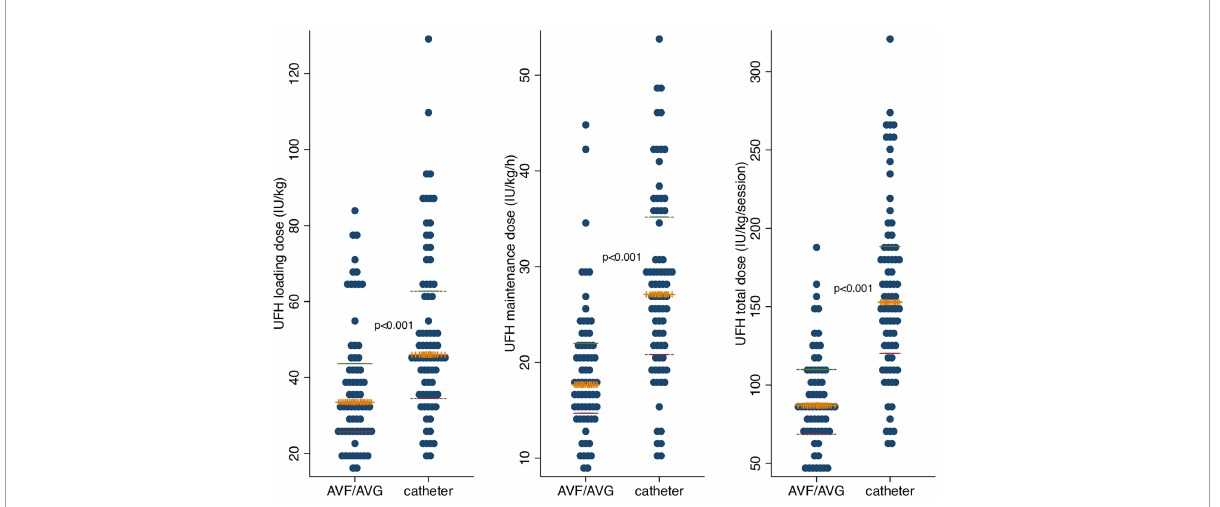
FIGURE3 UFH loading, maintenance and total dose within study subjects, according to vascular access. UFH, unfractionated heparin; IU, international units; kg, kilogram; h, hour; AVF/AVG, arteriovenous fistula/arteriovenous graft. The orange “+”-signs represent the median, the green dashed lines represent the 75th percentile and the red dashed lines represent the 25th percentile.